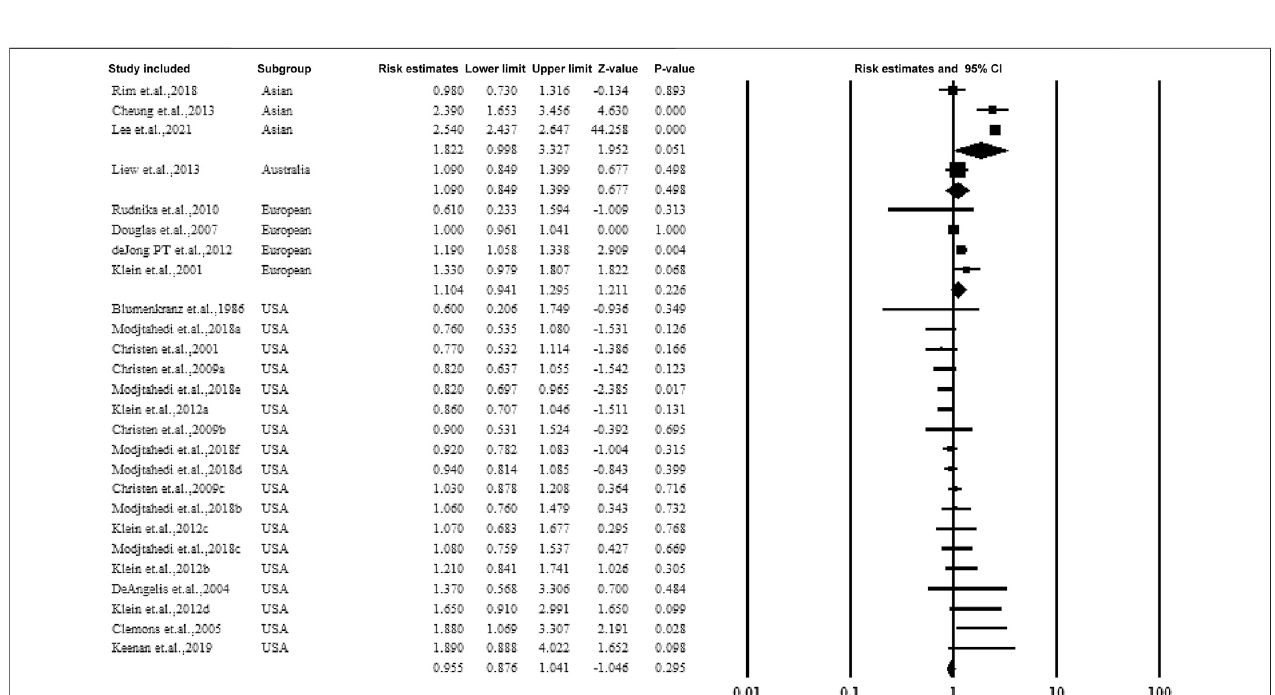
FIGURE 2 | Summarized overall estimate ratio.